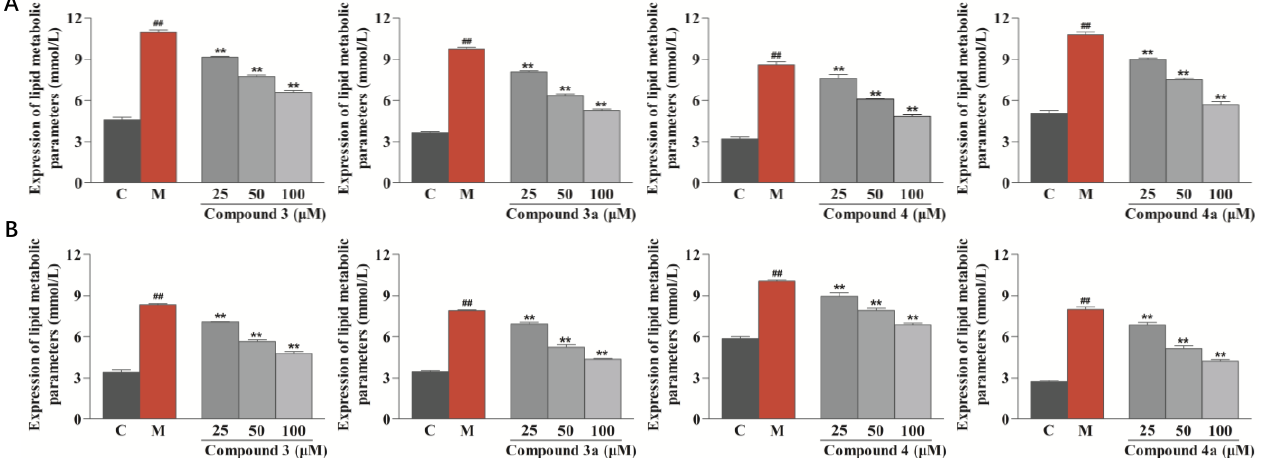
Figure 7. Effects of compounds 3 , 3a , 4 , and 4a on the contents of TC and FC in ox-LDL-treated RAW264.7 cells evaluated by ELISA. ( A ) Effects of compounds 3 , 3a , 4 , and 4a on the intracellular content of TC. ( B ) Effects of compounds 3 , 3a , 4 , and 4a on the intracellular content of FC. Results are expressed as the mean ± SD ( n = 3). Model group was subject to 75 μg/mL ox-LDL. ## p < 0.01 vs. control group; ** p < 0.01 vs. model group.